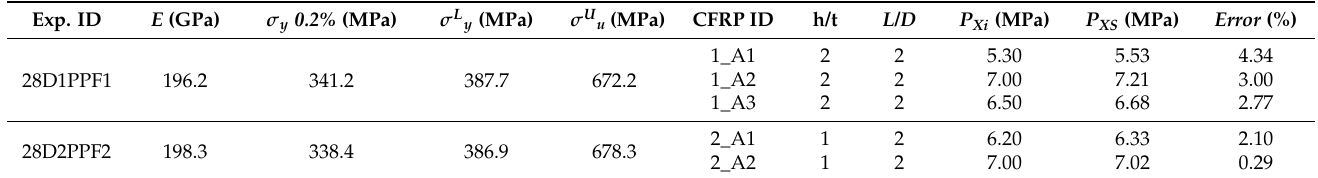
Table 3. Comparison between the numerical simulation and experiments in the literature [44].